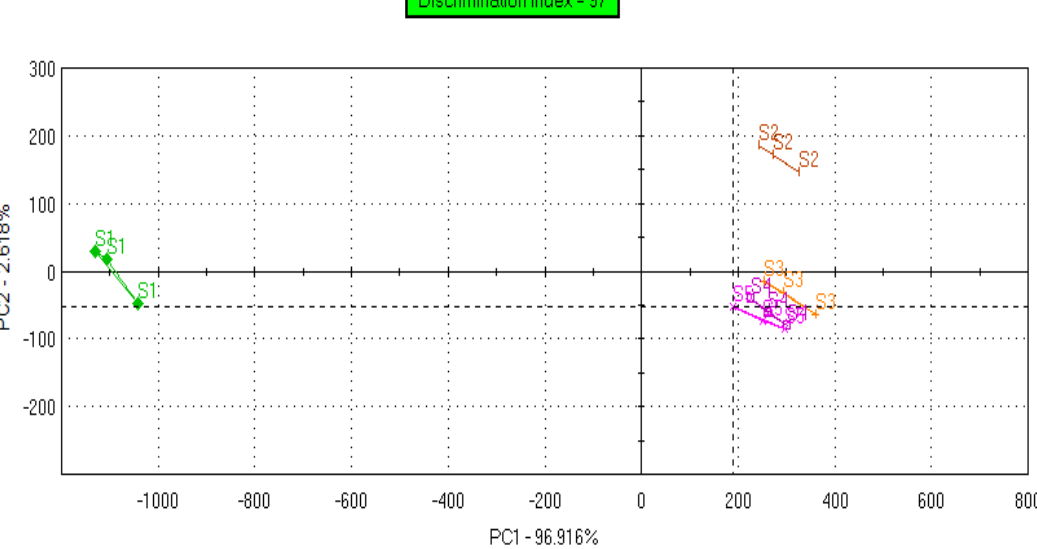
Figure 3. Astree ETongue voltage signals between preparations of sample 1, sample 2, sample 3, sample 4 and sample 5. Sample 1: Xylocaine ® , Sample 2: Xylocaine ® + 0.338% CTE + 0.09% sodium saccharine, Sample 3: Xylocaine ® + 0.184% CTE + 0.09% sodium saccharine, Sample 4: Xylocaine ® + 0.414% RAS + 0.09% sodium saccharine, Sample 5: Xylocaine ® + 0.237% RAS + 0.09% sodium saccharine.